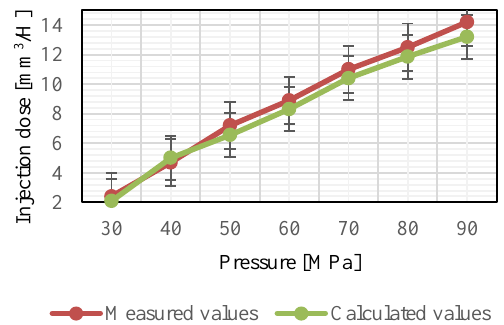
Fig. 5. Comparison of measured and calculated parameters for the injector control time of 475 µs